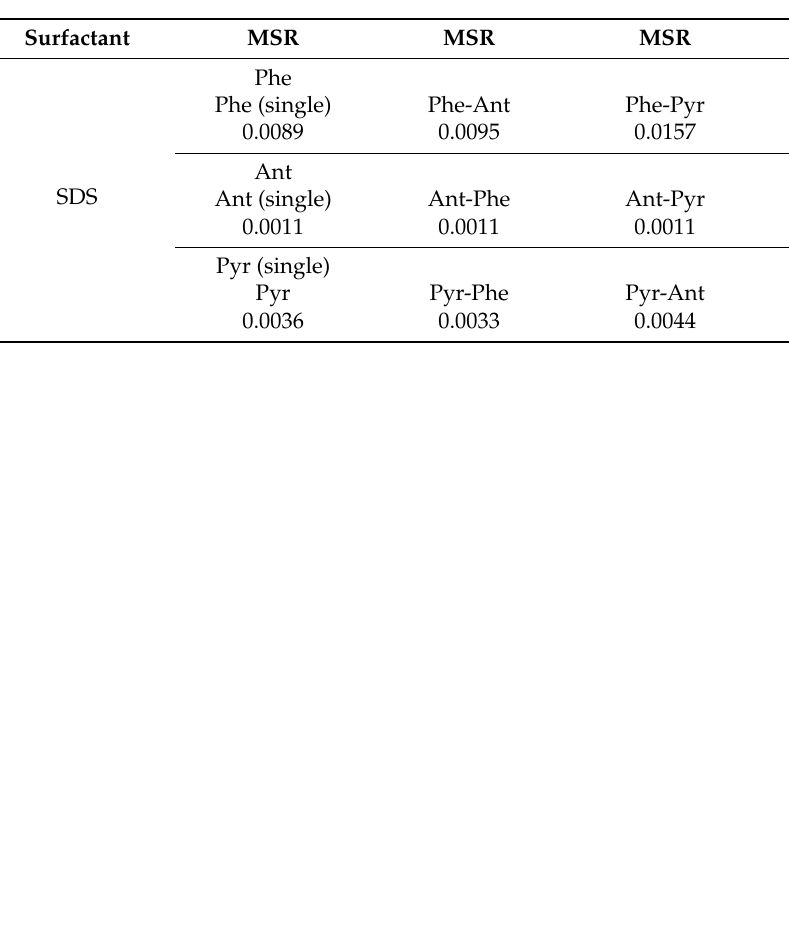
Figure 7. The solubility of Phe ( A ), Ant ( B ) and Pyr ( C ) in single, binary or ternary solubilization systems in SDS micellar solution. Table 3. MSR values of Phe, Ant and Pyr in single, binary or ternary solubilization systems in SDS micellar solutions.